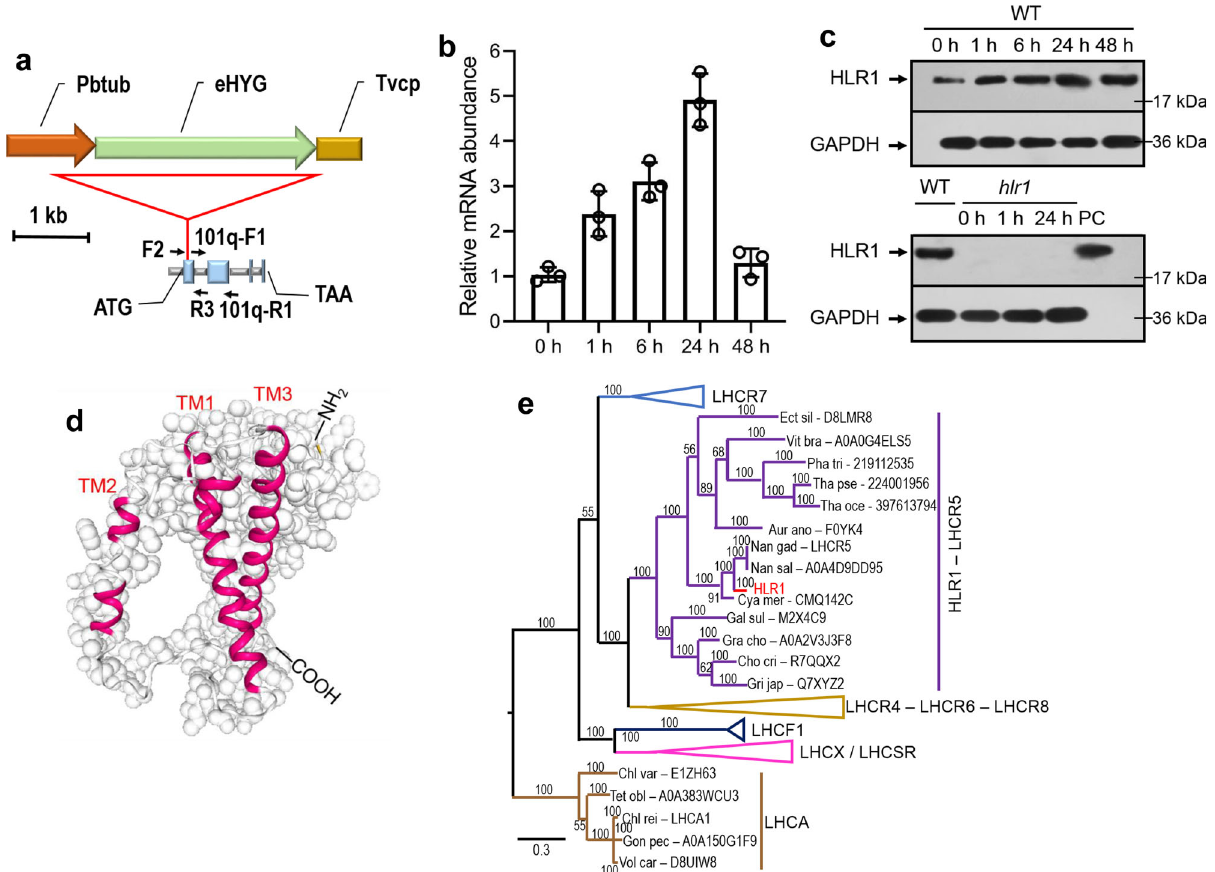
Fig. 2 Molecular and biochemical analysis of HLR1. a A schematic representation of the pMEM2 cassette insertion site in the genome of the hlr1 mutant. The red-line triangle represents the insert. Thick arrows indicate the orientation of the positive strand of the eHYG gene conferring resistance to hygromycin B. The HLR1 gene map is shown in a 5 ′ to 3 ′ direction from left to right, with exons and introns represented by fi lled boxes and connecting lines, respectively. Arrows indicate the primers used for qPCR (101q-F1 and 101q-R1) and amplifying regions across the ends of the insertion and the fl anking sequences (F2 and R3). b Quantitative RT-PCR of the HLR1 transcript in wild-type parental strain upon high irradiance. The primers 101q-F1 and 101q-R1 were used for qPCR. Data are presented as means ± SD ( n = 3). All primers are listed in Supplementary Data 5. c Immunoblot analysis of HLR1 protein expression in WT and hlr1 . Protein samples from the hlr1 mutant were taken from dark-acclimated cells or following high irradiance for the indicated